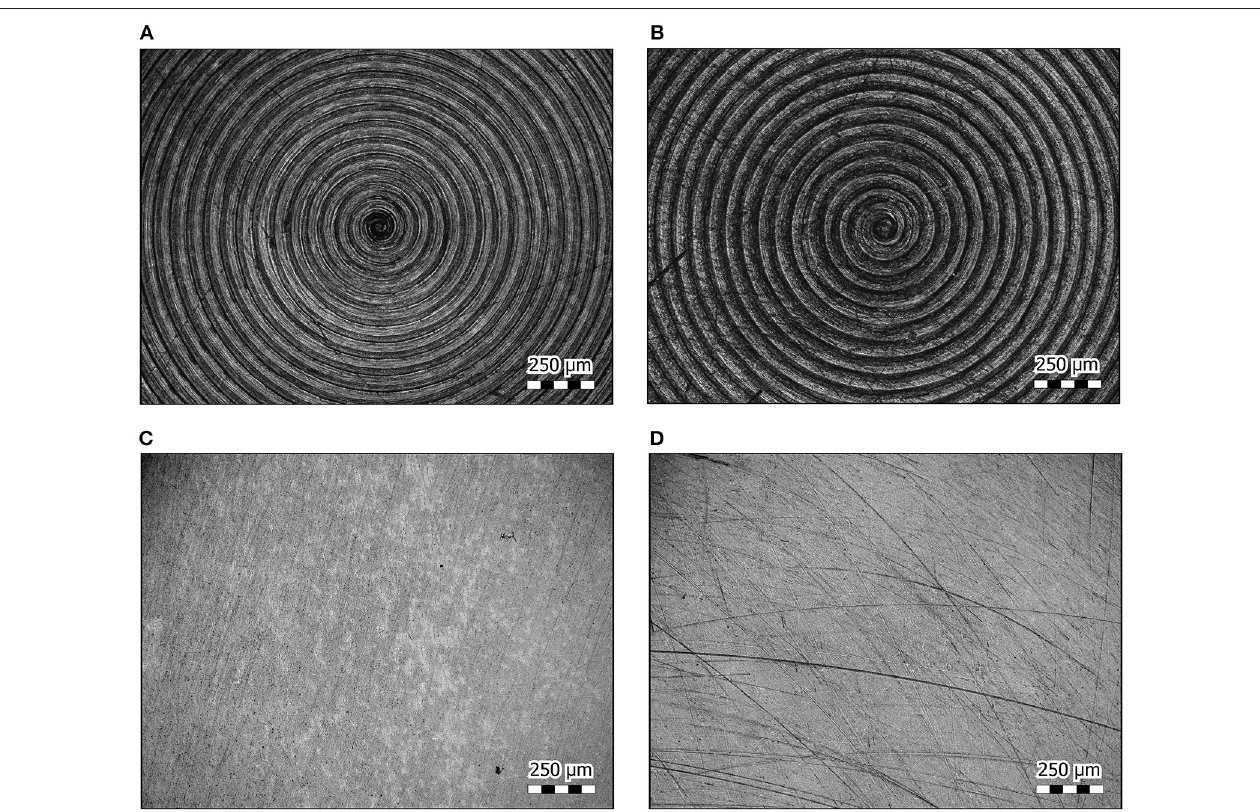
FIGURE 4 | Optical micrographs of the cup wear surfaces (A) original UHMWPE, (B) original x-linked UHMWPE (C) UHMWPE after 5 million cycles, (D) x-linked UHMWPE after 5 million cycles.